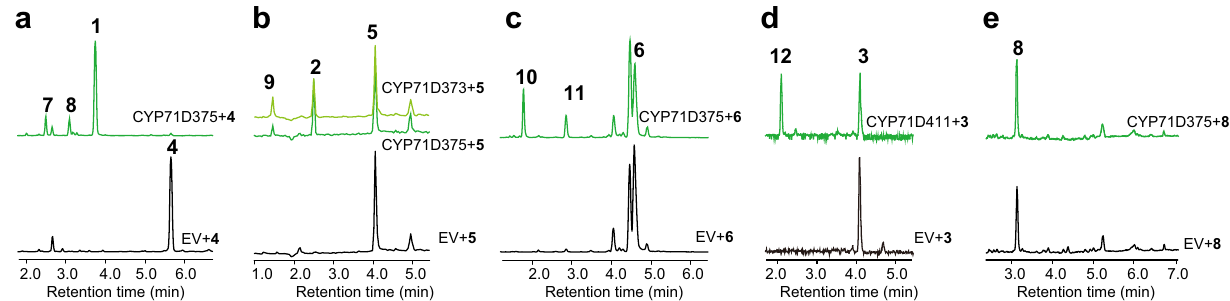
Fig. 5 Catalytic activity of targeted CYP71D subfamily members with putative tanshinone intermediates accumulating in CYP71Ds -RNAi plant roots. Extracted ion chromatograms showing the in vitro catalytic activity of ( a ) CYP71D375 with 4 . b CYP71D373 and CYP71D375 with 5 . c CYP71D375 with 6 . d CYP71D411 with 3 . e CYP71D375 with 8 . In each case, enzyme-mediated activity is indicated by the green chromatograms (with the relevant enzyme noted), while those for the empty vector (EV) negative control assays are in black.